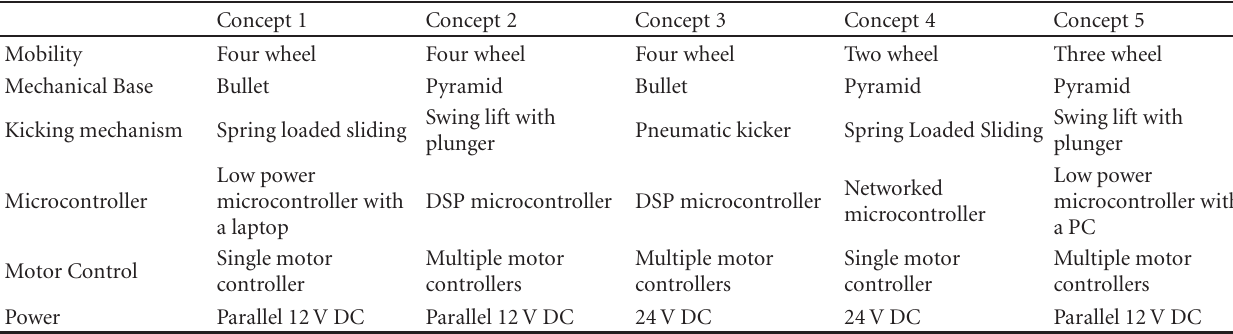
Table 2: Five conceptual